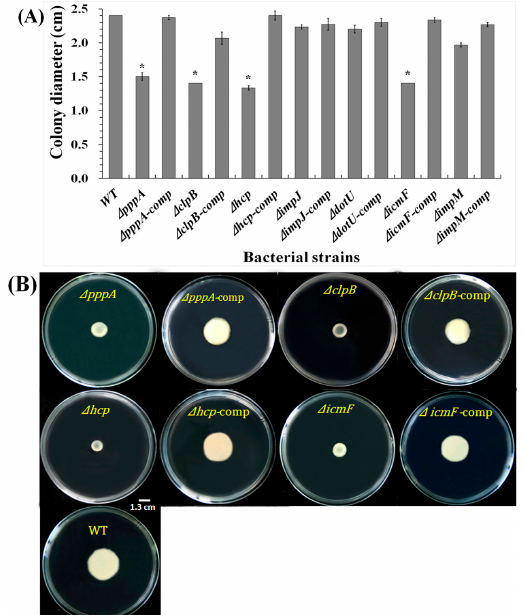
Figure 8. The mutation of the T6SS genes pppA , clpB , hcp and icmF inhibited the swimming motility of Acidovorax avenae subsp. avenae strain RS-2. Statistically significant difference (0.01 < * p < 0.05 by student’s t -test) was found between the T6SS mutants and the corresponding complemented strains or the wild-type ( A ). The swimming motility was determined by measuring the diameters of bacterial colony on the plates from three independent experiments ( B ).